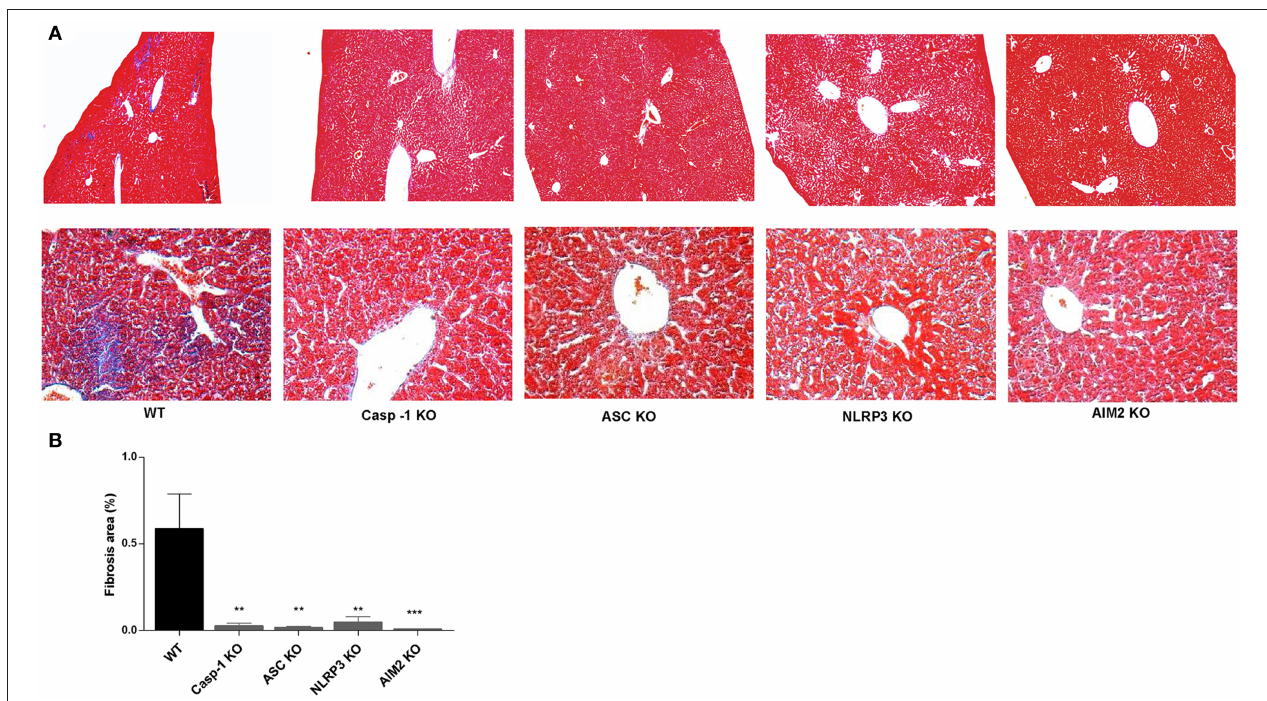
FIGURE 7 | NLRP3 and AIM2 influence liver fibrosis in livers from B. abortus -infected mice. Representative photomicrographs of liver sections from control mice, B. abortus- infected mice WT, Casp-1, ASC, NLRP3, and AM2 KO mice (n5) stained with Masson’s trichrome staining. The top panels show images taken at the original magnification ( × 100), and the bottom panels show a detail of collagen patches (magnification, × 400) (A) . Collagen-positive areas were quantified using Image Pro-Plus 6.0 software (B) . Data are given as the means ± SD from at least three individual experiments. ** P < 0.01; *** P < 0.001 vs. wild type